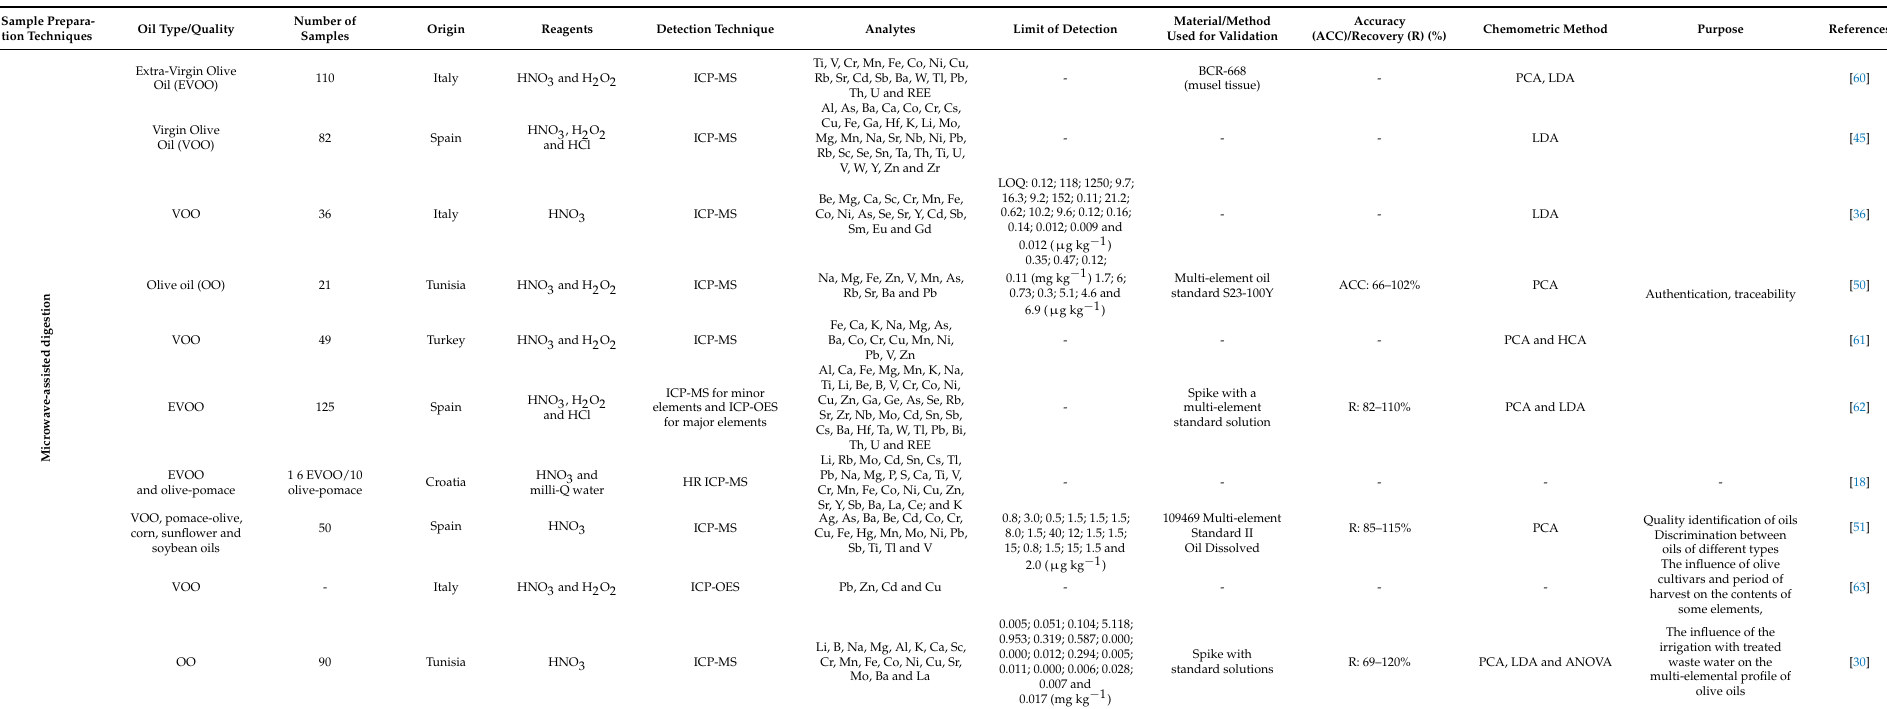
Table 1. Determination of trace elements in olive oil and other vegetable oils by means of spectrometric techniques following different sample preparation techniques. SamplePrepara-